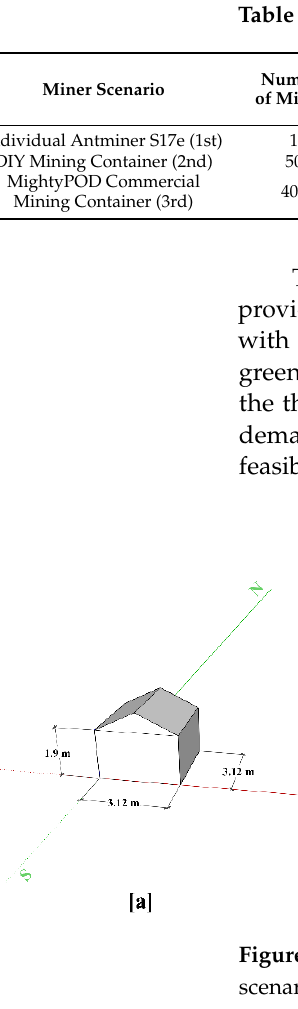
Figure 10. Daily heating demand of the greenhouses in London, ON. Table 4 corresponds to the characteristics of greenhouses designed under the climatic circumstances of five other locations, including Quebec (QC), Alberta (AL), California (CA), Texas (TX), and New York (NY). Referring to the table’s data, it can be deduced that